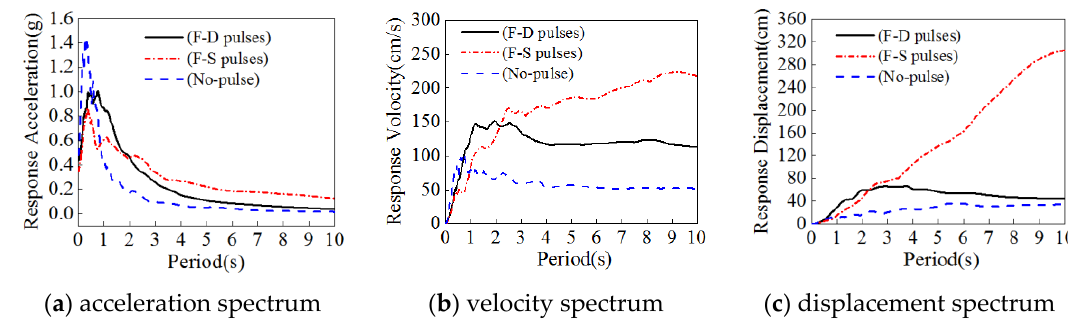
Figure 2. The average response spectrum curves of three groups of ground motions.